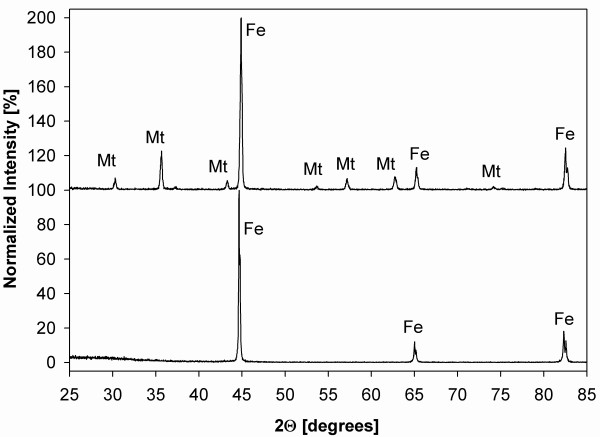
Normalized XRD patterns of unreacted (lower) reacted (upper) Fe0 showing the presence of magnetite (Mt).